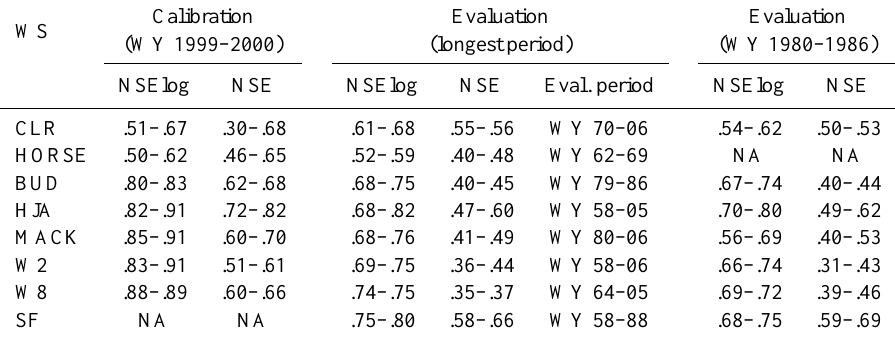
Table 4. Model performance across four chosen parameters.